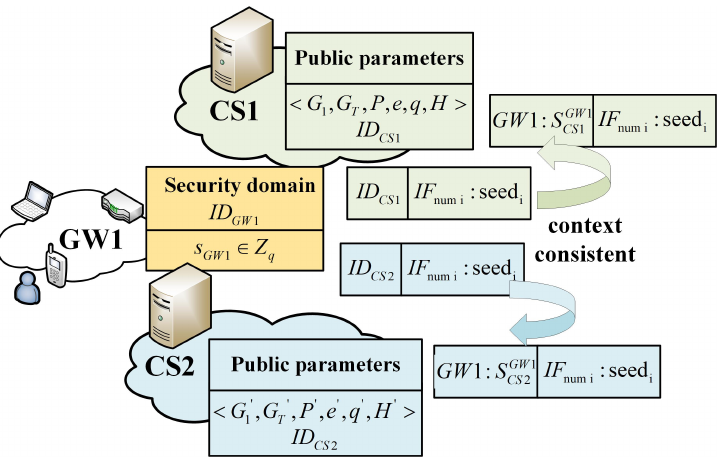
Figure 6. Context parameter status of the same device in different security